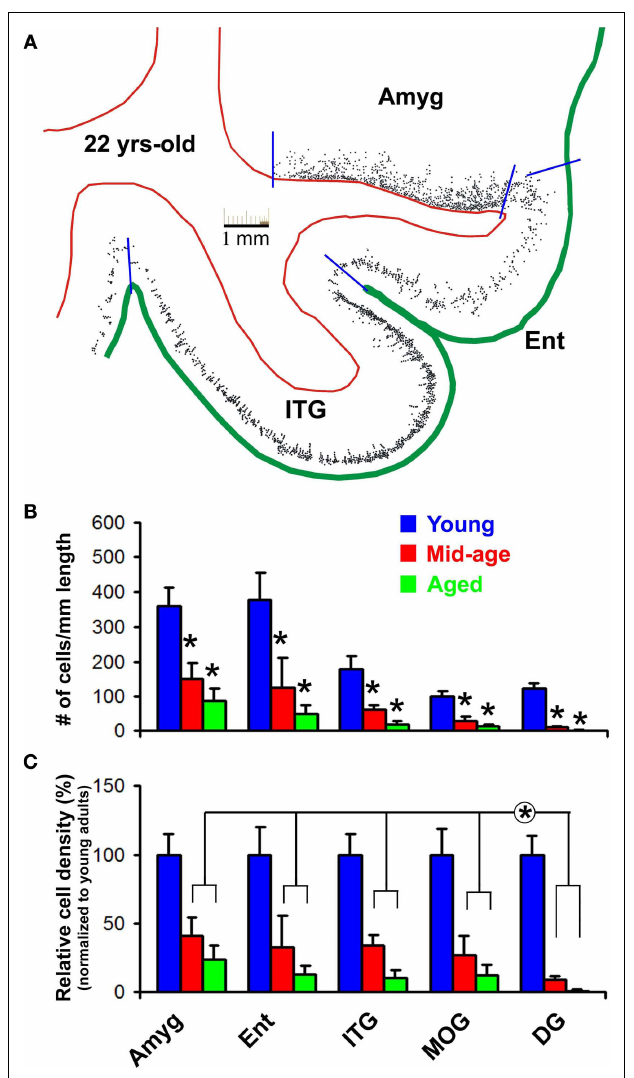
FIGURE 5 | Age-related decline of DCX + cells in the monkey forebrain based on densitometry over representative areas including the amygdala (Amyg), entorhinal cortex (Ent), inferior temporal gyrus (ITG), medial orbital gyrus (MOG) and dentate gyrus (DG). (A) shows an example of cell map reproduced from montaged 10 × microscopic images over a mid-amygdala section from the 22-year-old animal. Red lines mark the borders between the white matter and gray matter of the cortex or between the amygdala and cortical white matter, and green line defi nes the pial surface. Blue bars indicate the locations used to divide the cortical areas, and to defi ne the length of corresponding cellular bands in the amygdala (along the white matter border) and cortex (along the pial surface). Bar graph (B) shows cell densities (mean ± SD) in different areas in the three age groups. Bar graph (C) represents averaged densities normalized to the mean densities of corresponding regions in the young adult group (i.e., defi ned as 100%). Statistic analyses indicate a signifi cant (*) reduction of DCX + cells with age in all analyzed areas (B) , and a signifi cantly greater decline of cells in the DG relative to the amygdala and cortical areas (C)